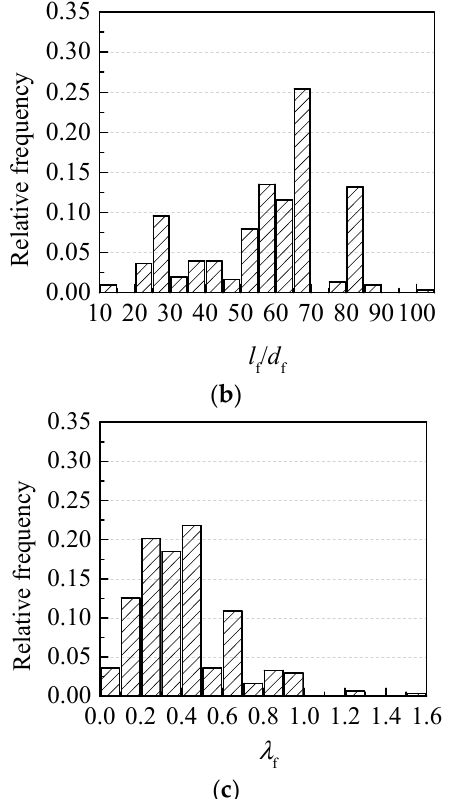
Figure 5. Probability distribution of steel fiber in SC-SFRC: ( a ) length l f ; ( b ) aspect ratio l f / d f ; and ( c ) fiber factor λ f .